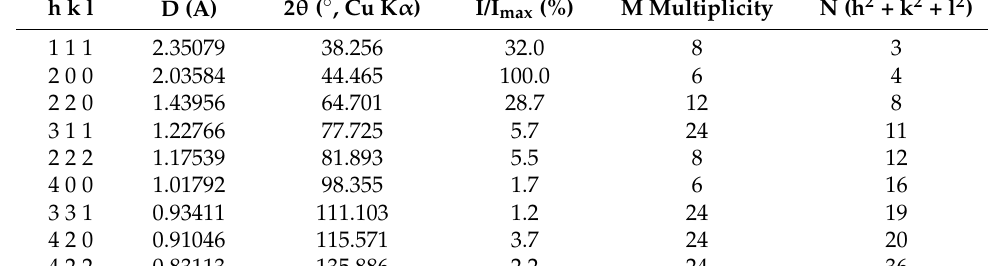
Table 1. Elemental analysis results on both sides of the flakes of the free-standing Ti 1 − x Al x N layer using WDS and EDS (flake surface was ion polished before elemental analysis) and calculated for stoichiometric coefficient (x).